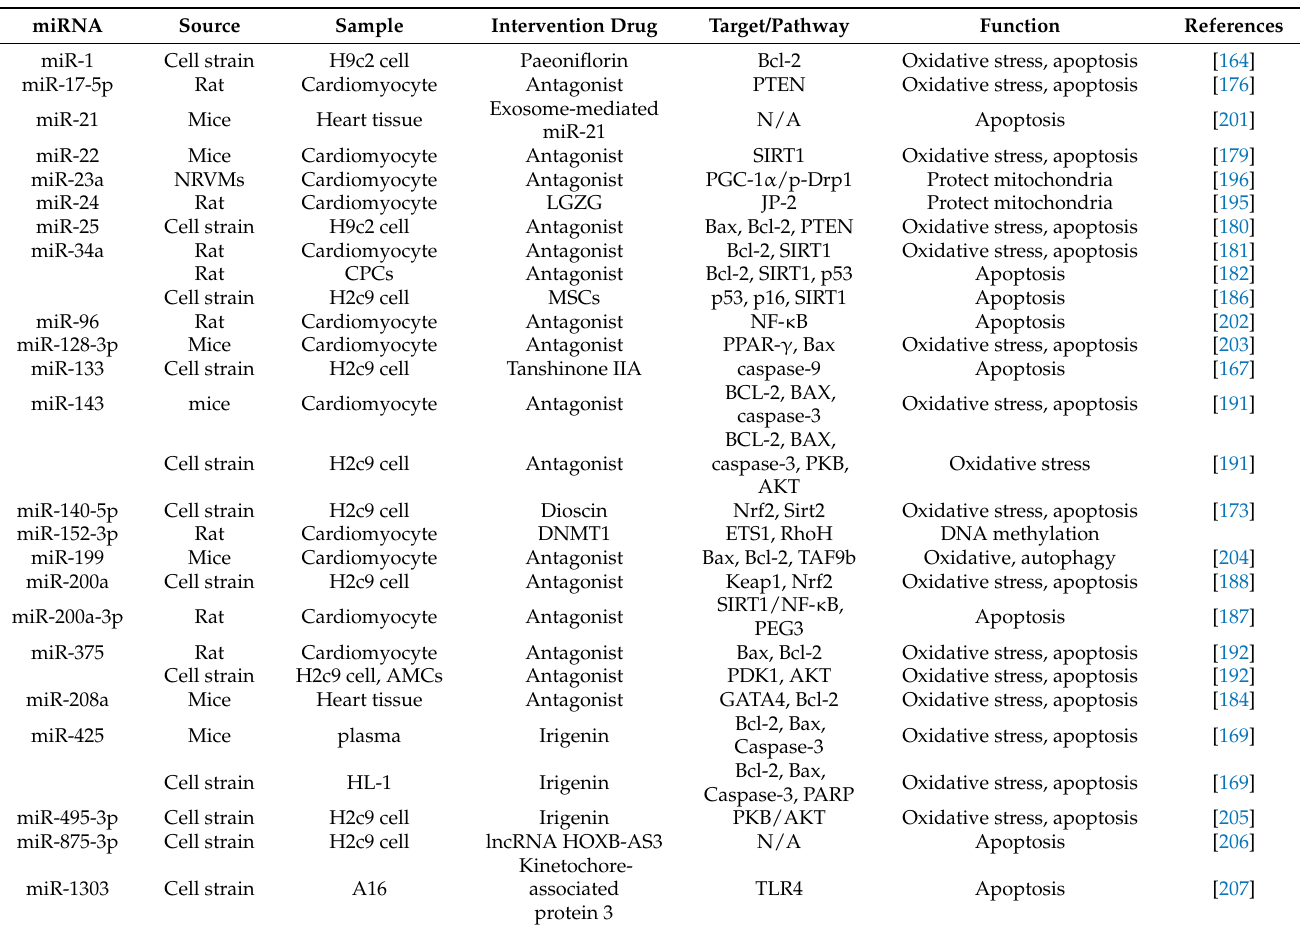
Table 2. As the therapeutic target of DIC, the regulatory role of miRNA in